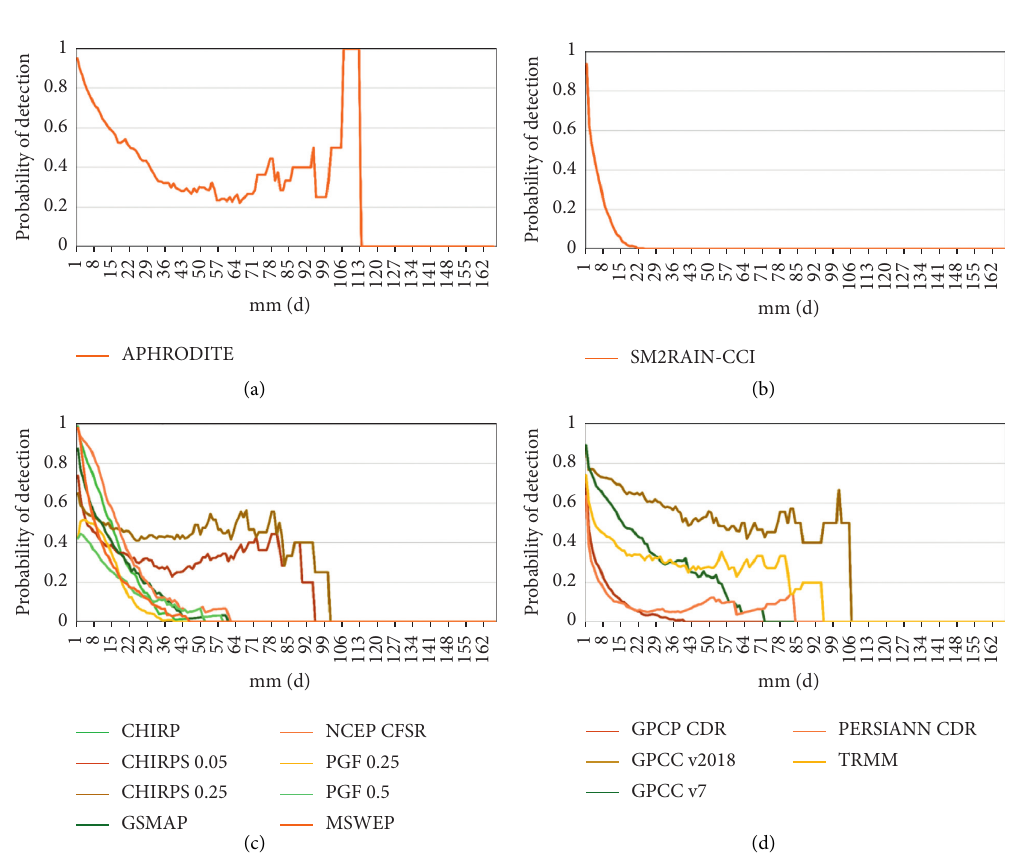
Figure 5: Line graphs indicating POD were plotted for (a) gauge-based product, (b) satellite-only product, (c) reanalysis products, and (d) gauge-adjusted products against IMD gridded